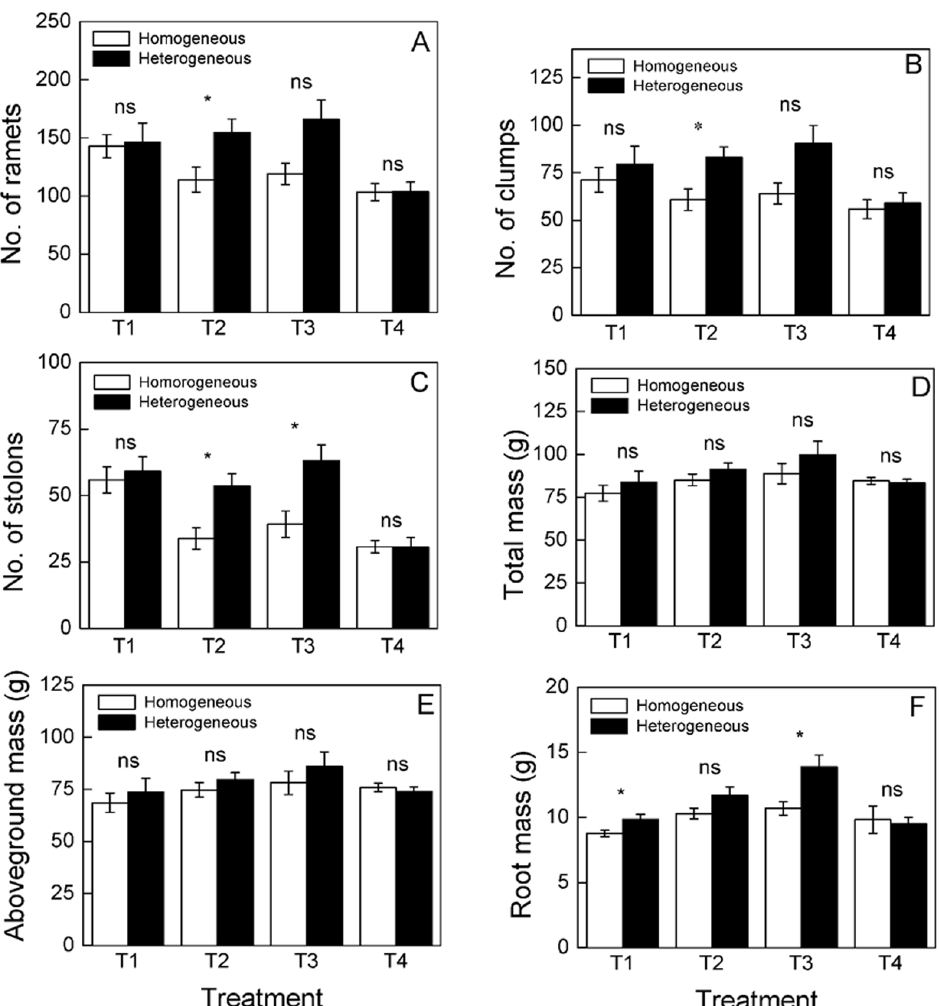
Figure 4. Different responses of growth characters of Buchloedactyloides between homogeneous and heterogeneous patches of the same treatment at clonal fragment level. The growth characters include number of ramets, clumps, stolons, aboveground mass, root mass and total mass. Mean values ( 6 S. E.) of number of ramets (A), number of clumps (B), number of stolons (C), total mass (D), aboveground mass (E) and root mass (F) between the homogeneous and heterogeneous patches of the same treatment are given. * means P , 0.05. Mean values ( 6 S. E.) of the growth characters in the heterogeneous (D) and homogeneous patches (E) are given. * means P , 0.05. ns means P . 0.05. Treatment codes are in Figure